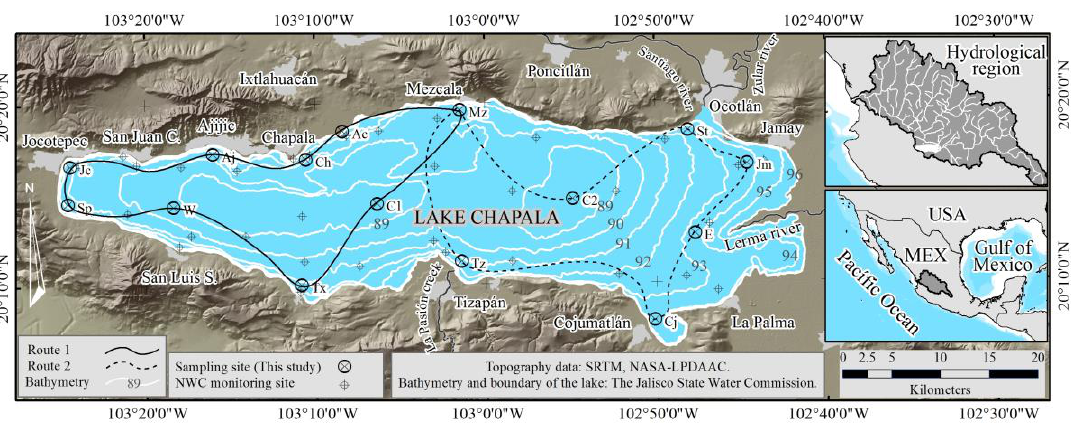
Figure 1. Map of Lake Chapala. Abbreviations: National Water Council (NWC); Shuttle Radar Topography Mission (SRTM); National Aeronautics and Space Administration (NASA); and The Land Processes Distributed Active Archive Center (LPDAAC).